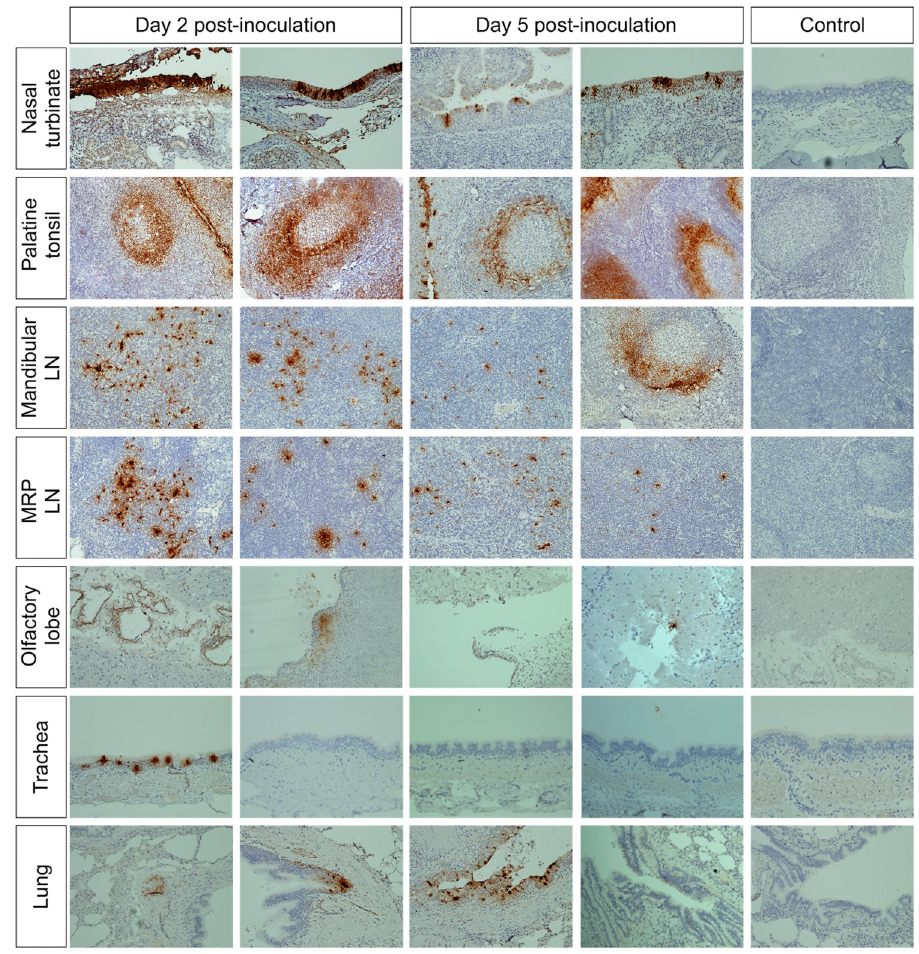
Fig 8. Immunohistochemistry (IHC) in tissues from white-tailed deer inoculated with SARS-CoV-2. SARS-CoV-2 labeling in the tissues of the inoculated WTD by IHC showing staining for the SARS-CoV-2 N protein (brown stain) in several tissues on days 2 and 5 post-inoculation (pi). Tissue sections were counter stained with hematoxylin. Tissues from a control (uninoculated) animal were included in all IHC stains.